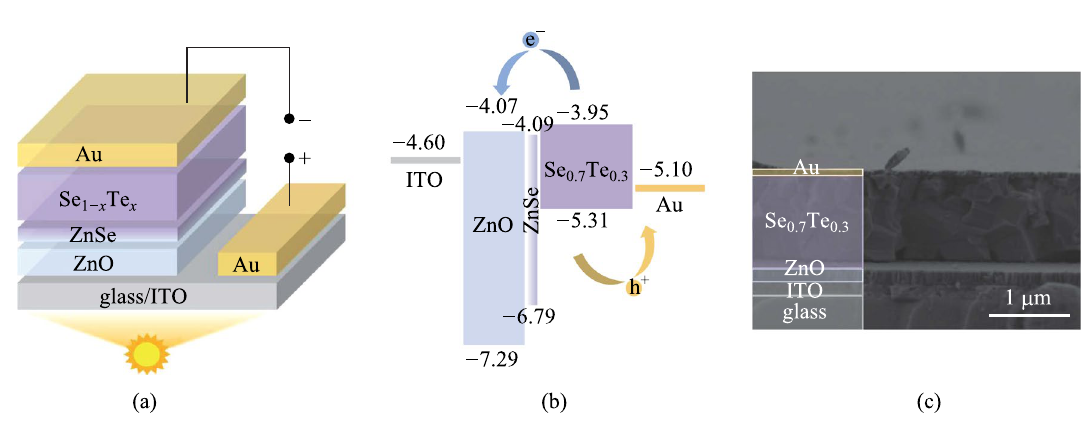
a Structure diagram of the Se 0.7 Te 0.3 solar cells. b Band alignment diagram and c cross-section SEM image of ITO/ZnO/Se 0.7 Te 0.3 /Au solar